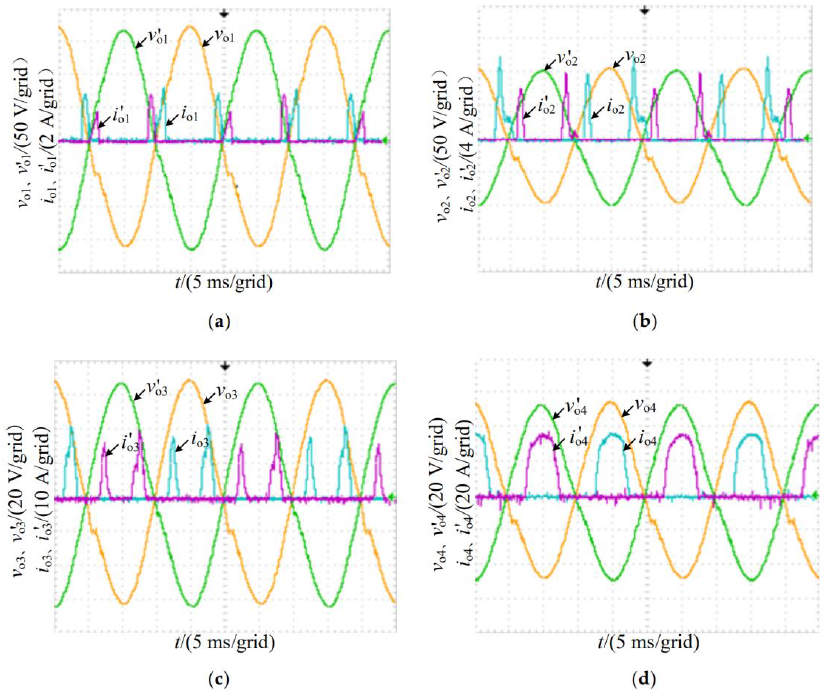
Figure 10. Voltage and current of each tap of transformer primary winding. ( a ) First stage voltage and current. ( b ) Second- stage voltage and current. ( c ) Third-stage voltage and current. ( d ) Fourth-stage voltage and current.